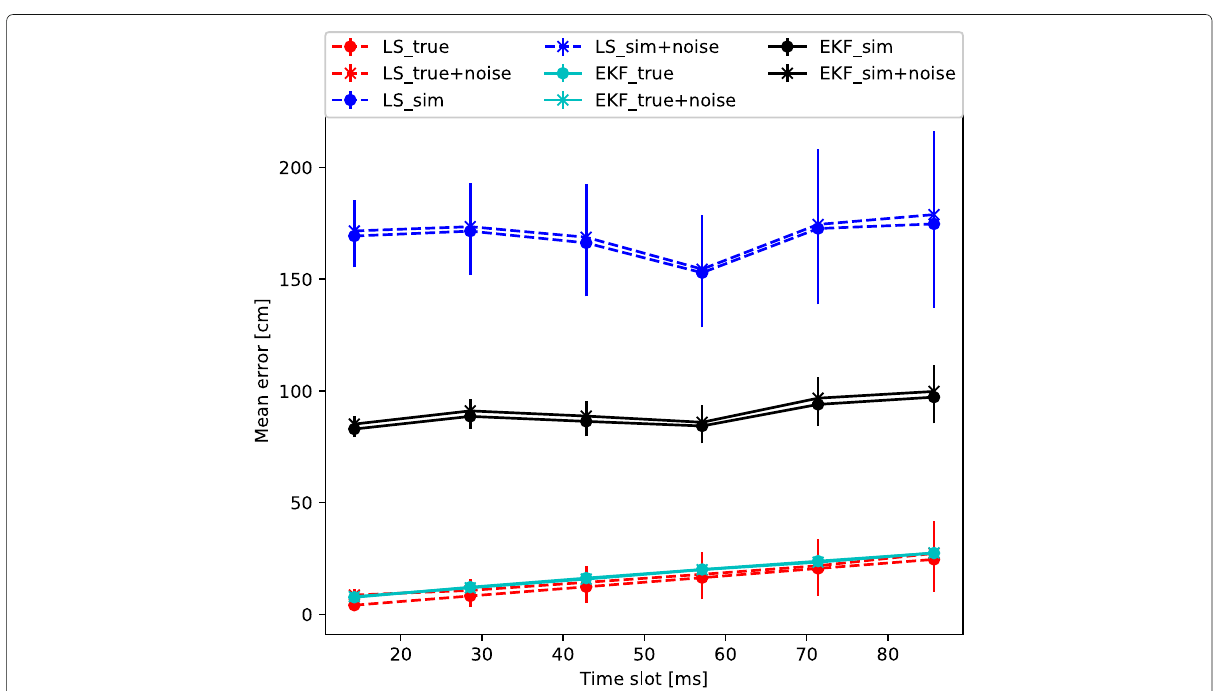
Fig. 7 The influence of the ranging slot length on the size of mean tracking errors